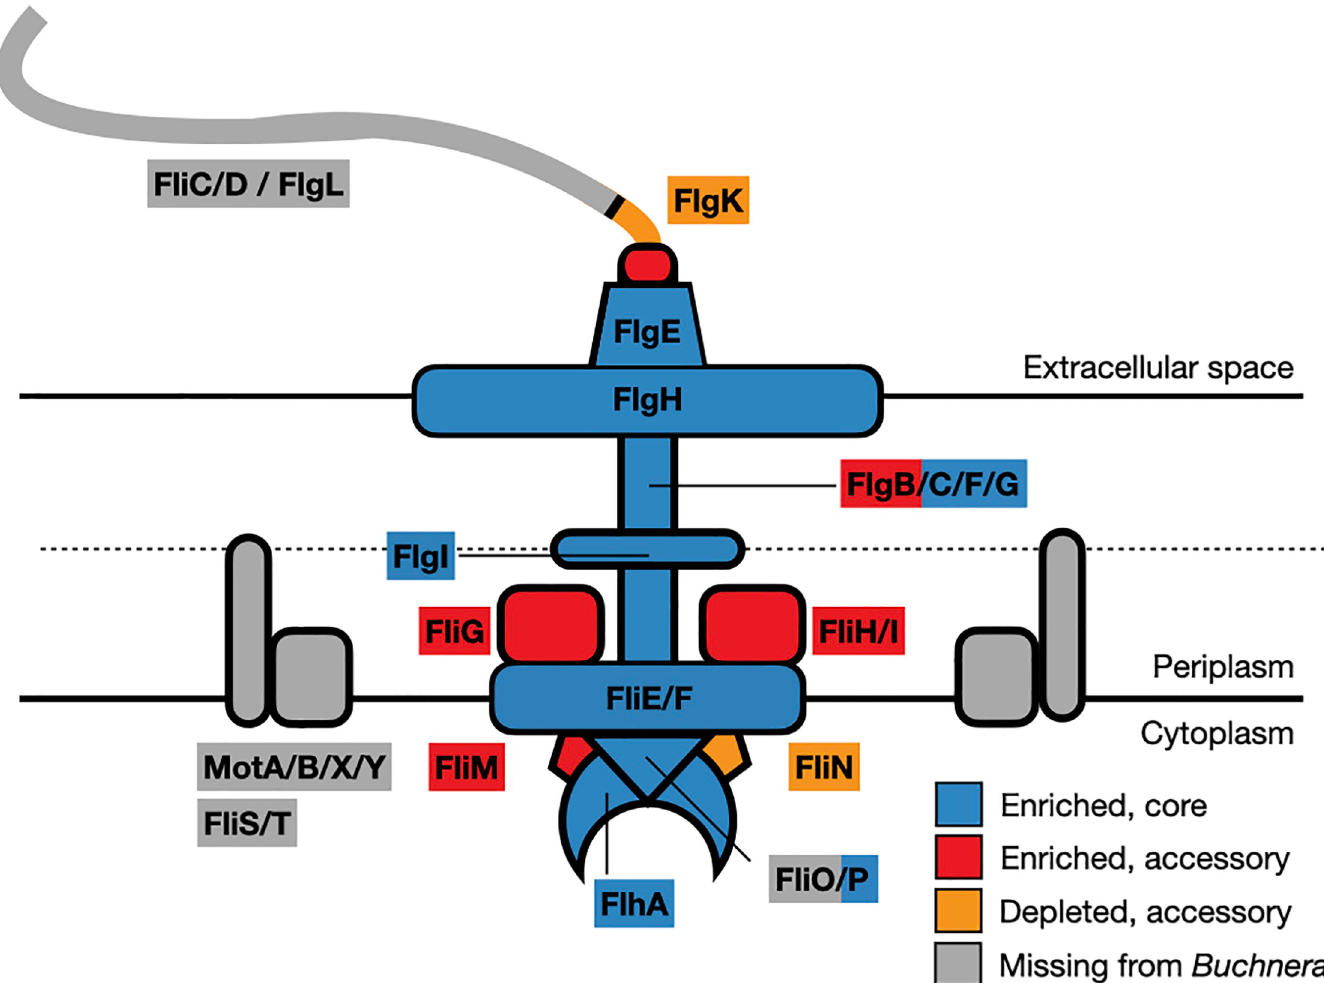
Fig 1. Cartoon diagram of the bacterial flagellum. Colors indicate which proteins are lost from Buchnera aphidicola of pea aphids and also the enrichment status of each retained protein at the final step of the procedure (Fig 2).